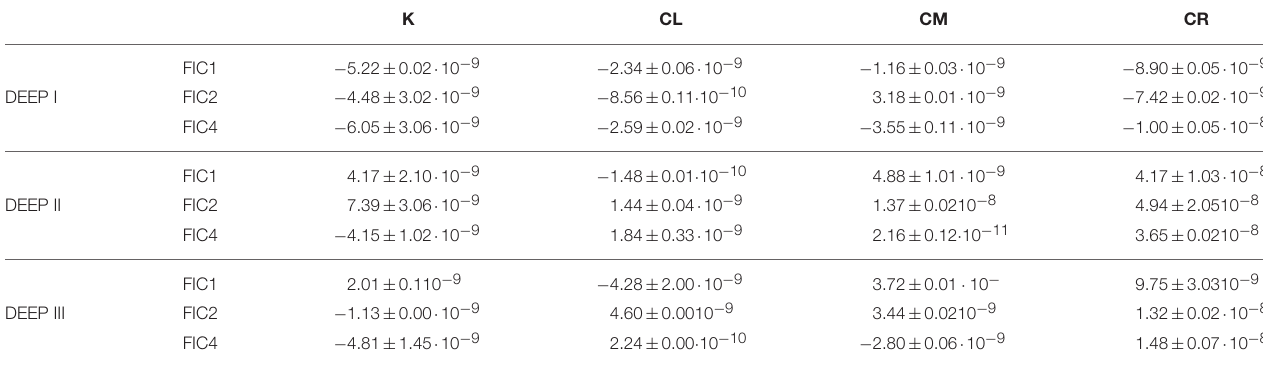
TABLE 4 | Overall production/consumption of humic-like fluorescence per cell [(FDOM at t final –FDOM at t 0 ) · (prokaryotes at t final –prokaryotes at t 0 ) − 1 ] for all the different treatments during the experiments (in R.U. · cells − 1 d − 1